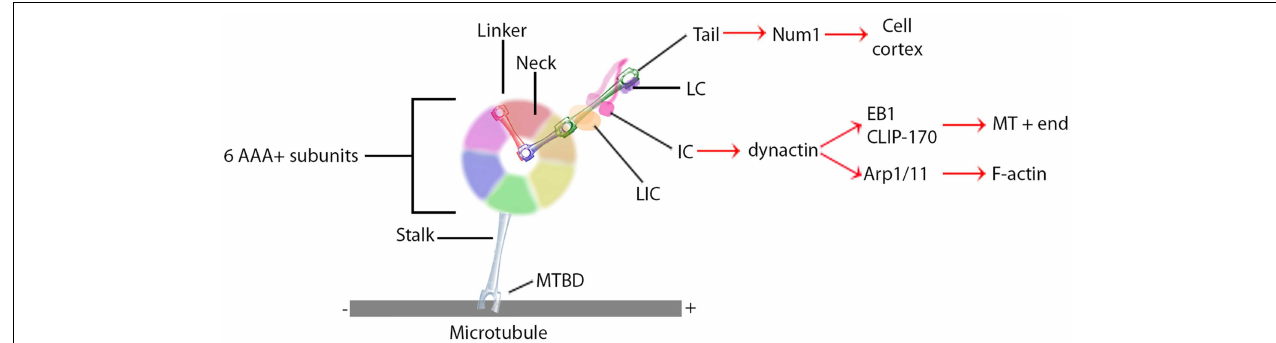
FIGURE 1 | General dynein complex structure and binding interactions. Black lines identify components of the core dynein complex whereas red arrows signify binding proteins or localizations. MTBD, microtubule binding domain; LIC, light intermediate chain; IC, intermediate chain; LC, light